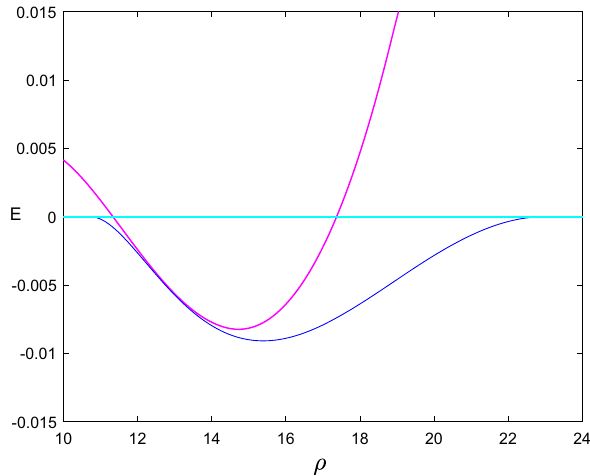
Fig. 3 The relative value of Gibbs free energy G − G s with respective to ρ . G s is the Gibbs free energy of the s-wave solution, therefore the cyan line for the s-wave solution coincide with the horizontal axis. The magenta line denotes for the p-wave solution, and the blue line denotes for the coexisting s + p